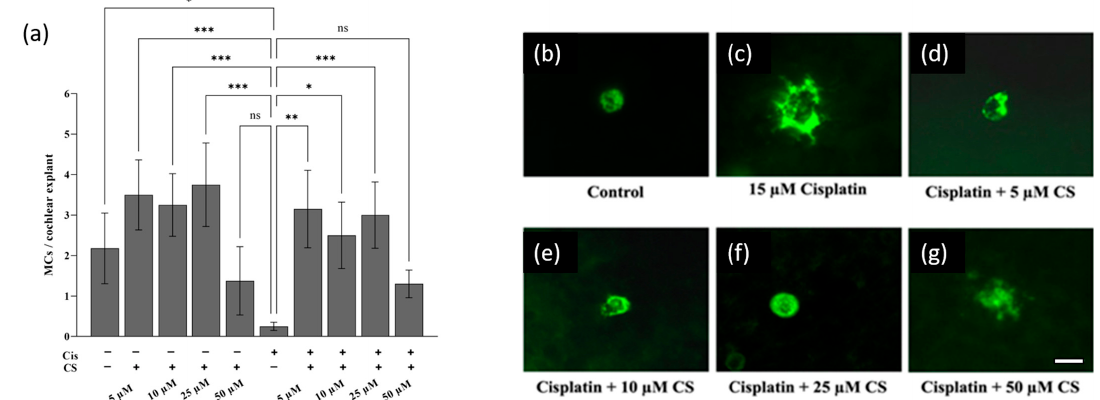
Figure 6. Cromolyn prevents cisplatin-induced MC degranulation in cochlear explants. ( a ) The control groups (n = 4 each) were either not treated ( − − ) or incubated for 24 h with 5, 10, 25, or 50 µM of cromolyn (CS, − +) and exposed to 15 µM cisplatin (Cis, + − ). The treatment groups (n = 4 each) were pretreated with 5, 10, 25, and 50 µM CS for 2 h and then exposed to 15 µM cisplatin for 24 h (+ +). The non-degranulated MCs were counted in the explant tissues. ( b – g ) Representative micrographs show MCs in the respective treatment groups. The MCs were labeled with avidin–Alexa Fluor ™ 488. The scale bar represents 10 µ m. The data were derived from four independent experiments and are reported as mean ± SEM. “ns” indicates not significant ( p > 0.05); * p < 0.05; ** p < 0.01; *** p < 0.001 (Kruskal–Wallis test with Dunn’s multiple comparison